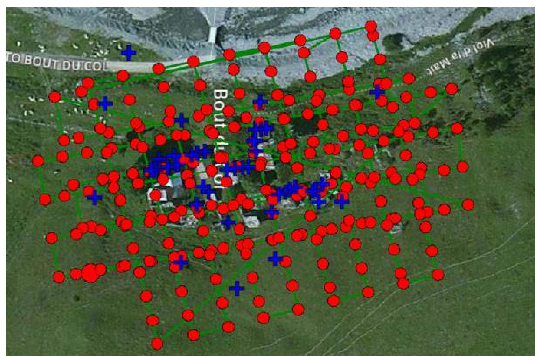
Figure 10. Flight plan (green lines), camera positions (red dots) and measured GCPs (blue crosses) - Zenmuse X4S